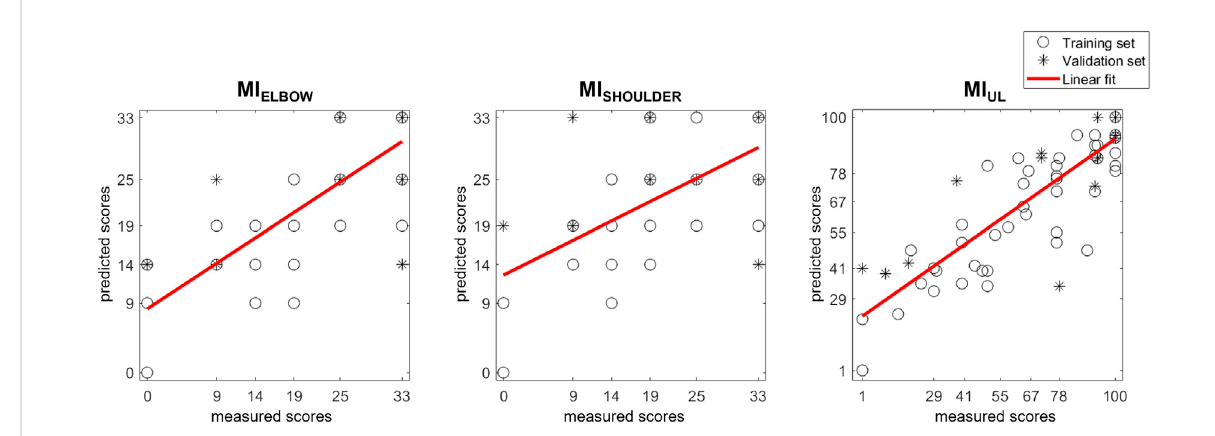
FIGURE 2 Scatter plot of MI scores prediction with SSV models. Each patient ’ s actual score was plotted together with the predictions generated by the models. Training and validation sets are depicted separately. The results of a linear polynomial fi tting are also